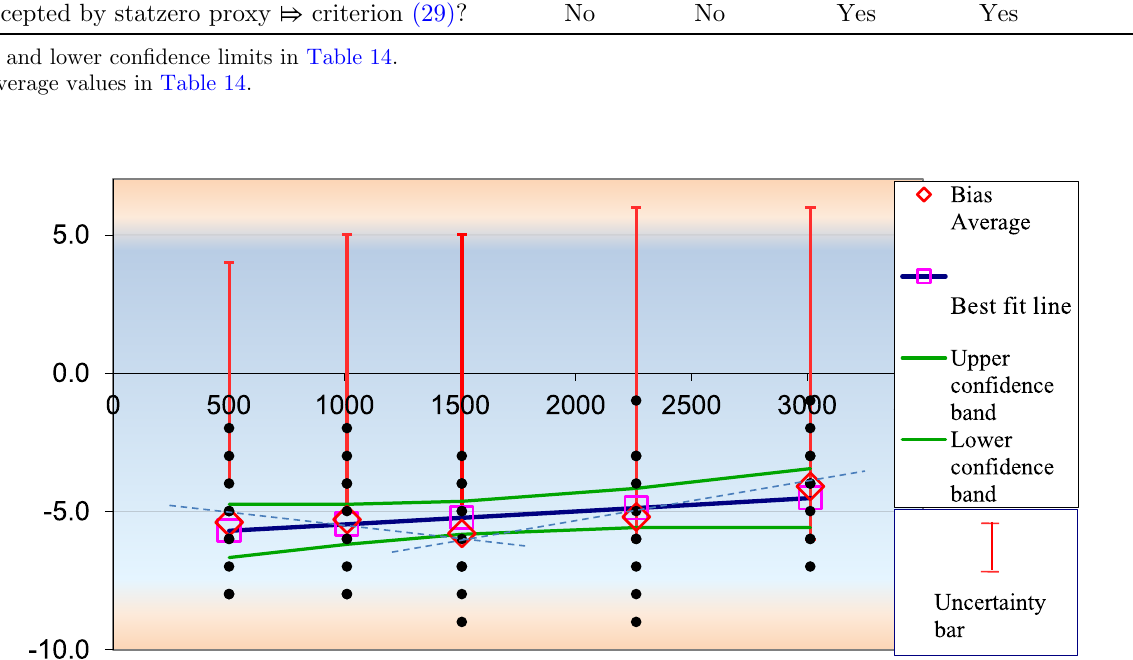
Fig. 6. Example 6, FAC-1, measurement system D: Linearity not acceptable. Reference values are on the x-axis in nm units [xo = R con (j)]. Bias data are on the y-axis in nm units (solid circles).